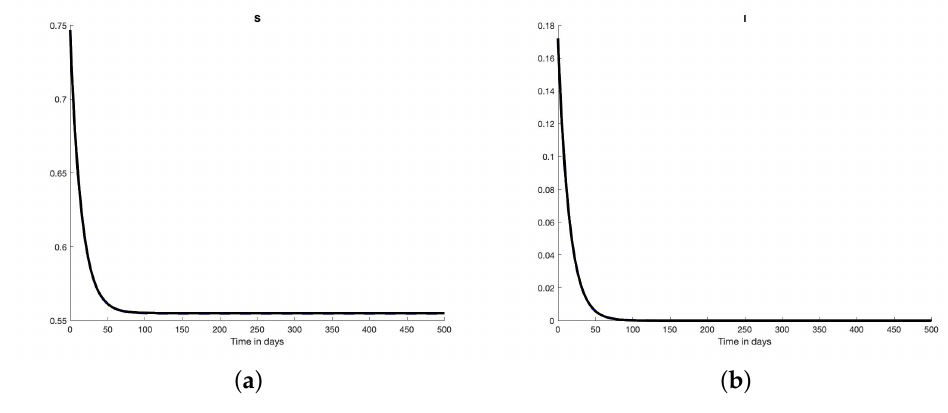
Figure 8. Scenario 4: States. ( a ) S and S ∗ (- -); ( b ) I and I ∗ (-